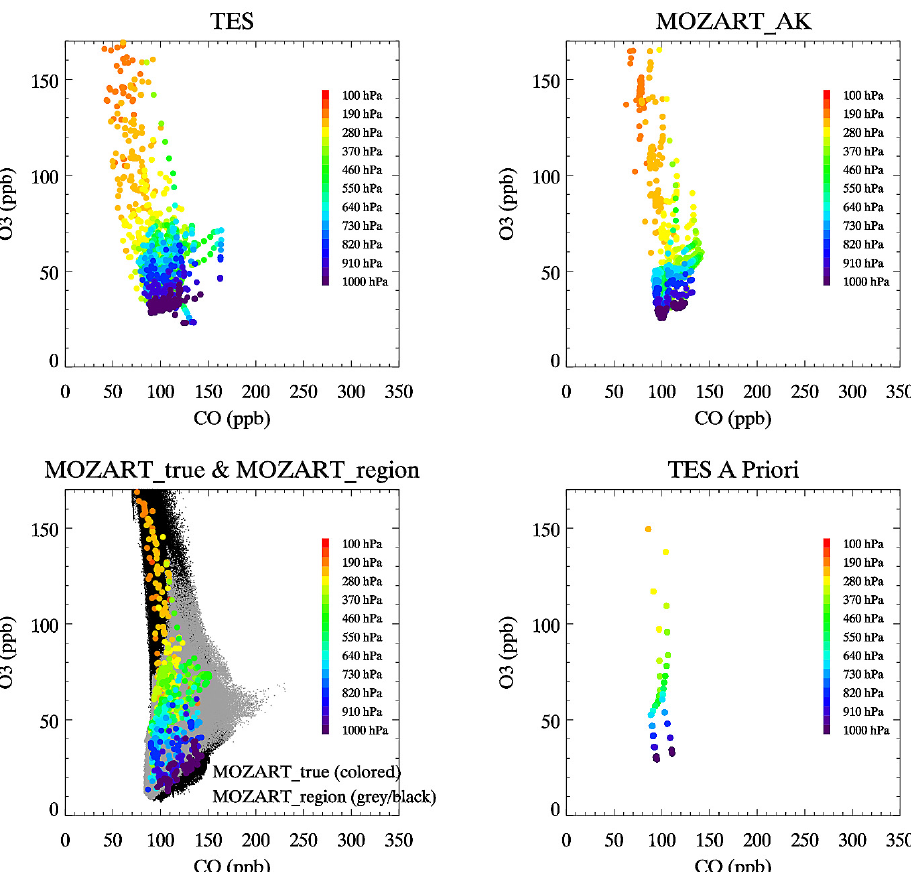
Fig. 7. As Fig. 3, but for TES CO and O 3 retrievals. Retrievals over Ocean (130–150W, 30–45N) for 15–30 June 2008. MOZART has been interpolated to the time, location and pressure grid (MOZART true) and convolved with the TES Averaging Kernels (MOZART AK). The bottom left panel further includes MOZART data for the entire region and time period with data within the 850–350mbar range colored in gray (MOZART region). The bottom right panel shows scatter plots for the TES a priori CO and O 3